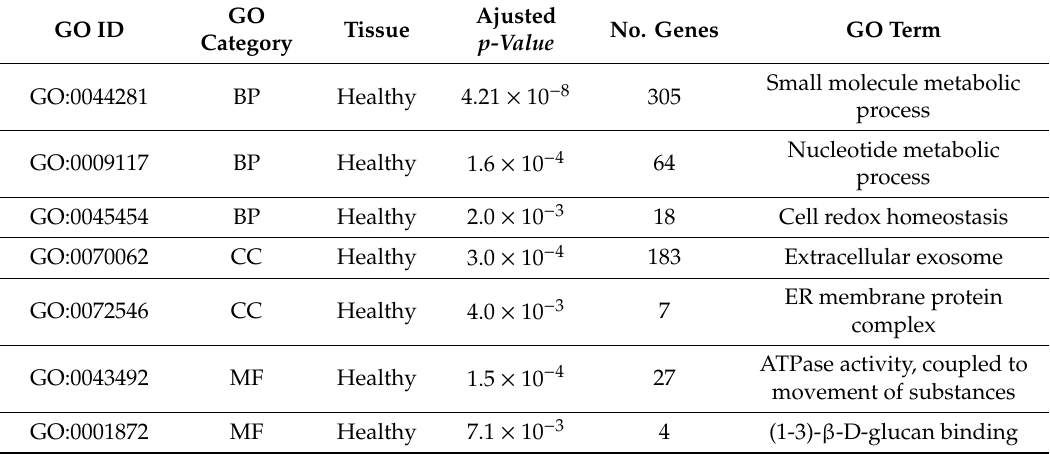
Table 1. Summary of the Gene Ontology (GO), showing Biological Process (BP), Molecular Function (MF), and Cell Component (CC) terms (FDR < 0.1) from differentially expressed genes between healthy and unhealthy Litopenaeus vannamei exposed to WSSV (White Spot Syndrome Virus), and resulting enriched pathways.